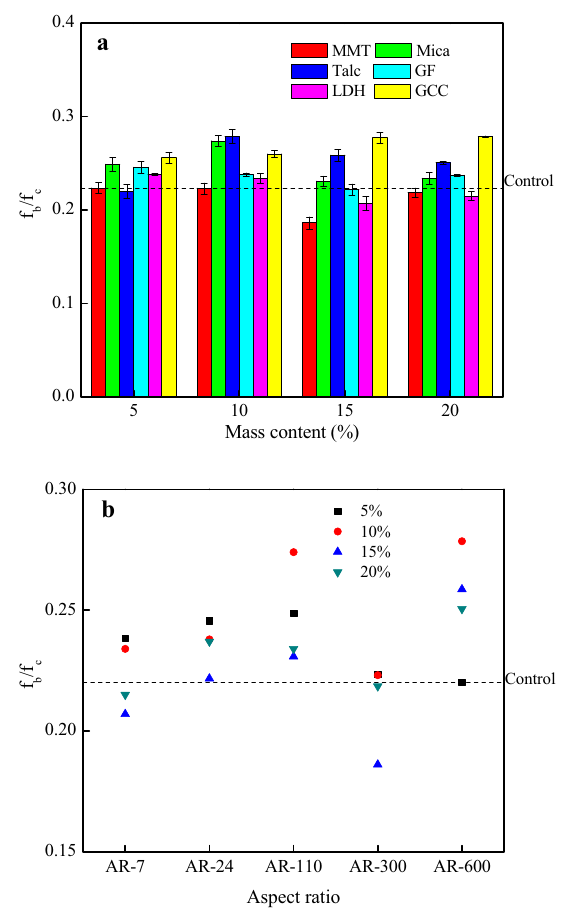
Fig. 3 F b /F c of the modified EECM with different fillers. a Filler contents; b aspect ratios of